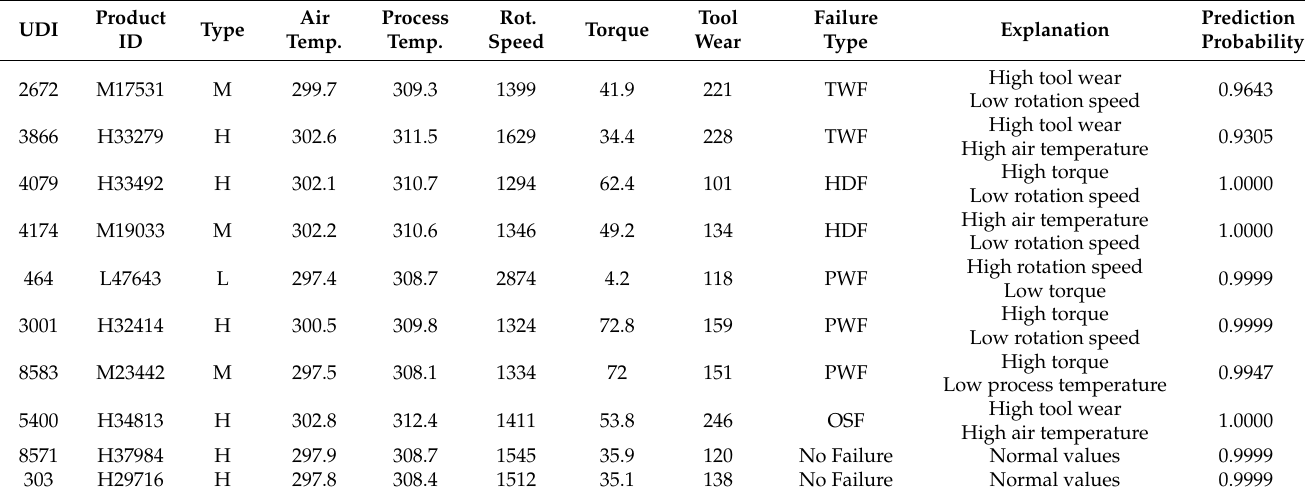
Table 5. Explanation of ML model predictions.